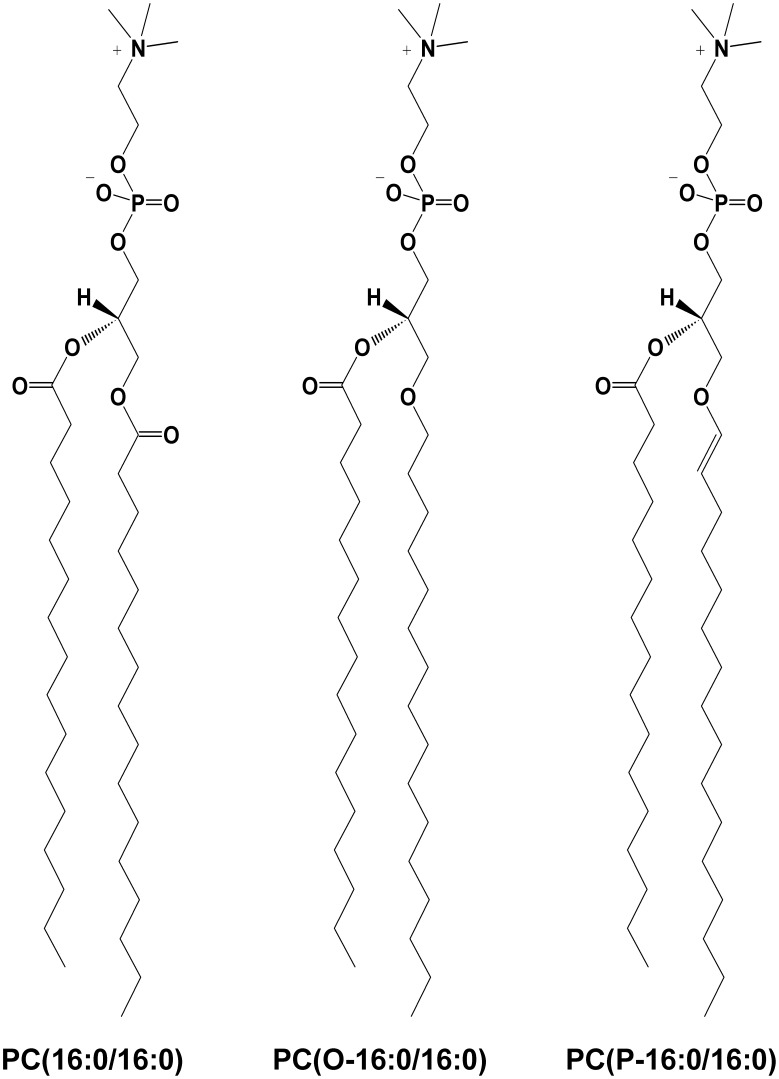
Structure of three glycerophosphocholine subclasses.PC(16:0/16:0), PC(O–16:0/16:0), and PC(P–16:0/16:0) are, respectively, indicated for 1,2–dihexadecanoyl–, 1–hexadecyl–2–hexadecanoyl–, and 1–(1Z–hexadecenyl)–2–hexadecanoyl– sn–glycero–3–phosphocholine.